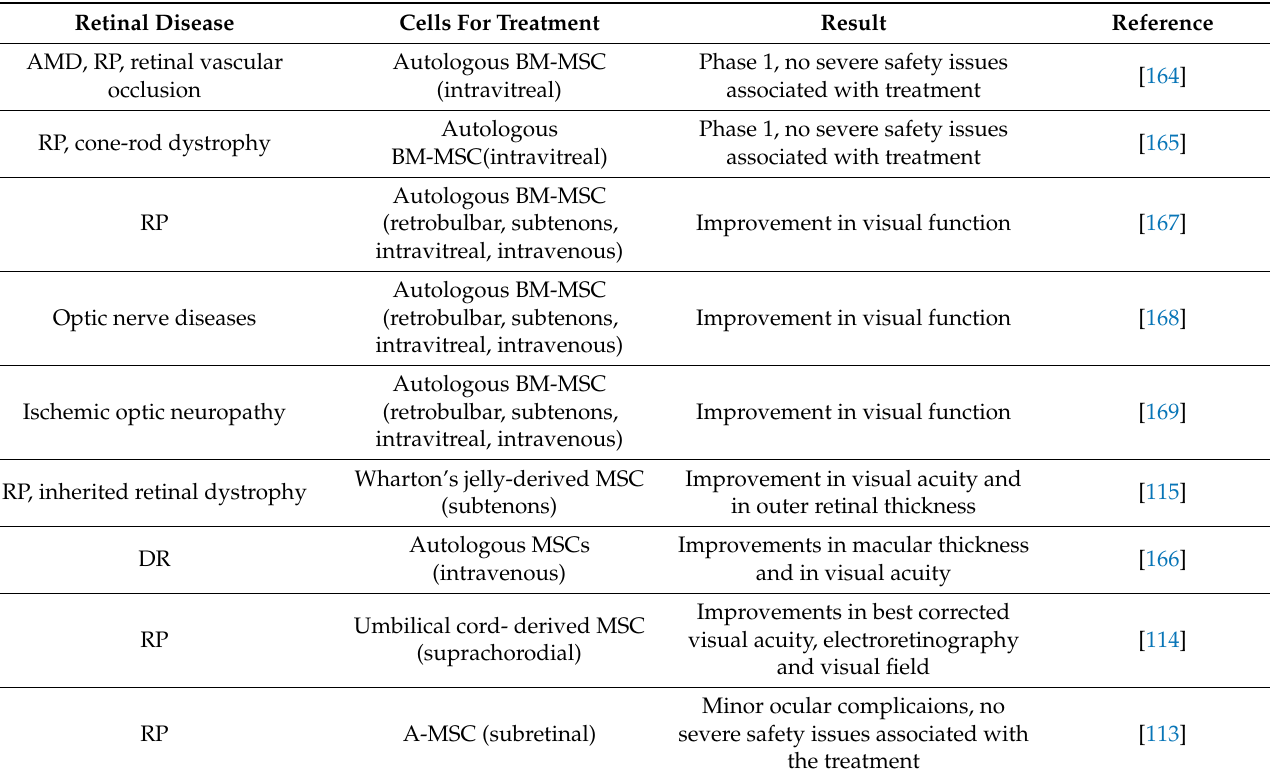
Table 2. Selected examples of clinical trials using MSCs for retinal degenerative diseases. Retinal Disease Cells For Treatment Result